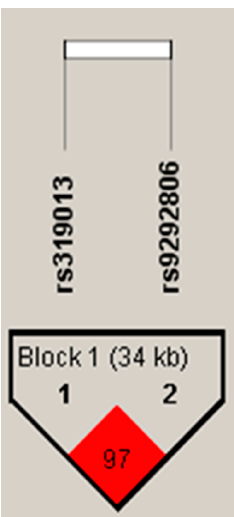
Figure 3. Linkage disequilibrium ( r 2 = 0.972) analysis between rs319013 and rs9292806 in the Emirati population, r 2 indicates the squared correlation coefficient between two SNPs. Table 4. Odds ratios of genotypes the PLCXD3 SNPs in control vs. T2DM and Non-MetS vs. MetS groups.